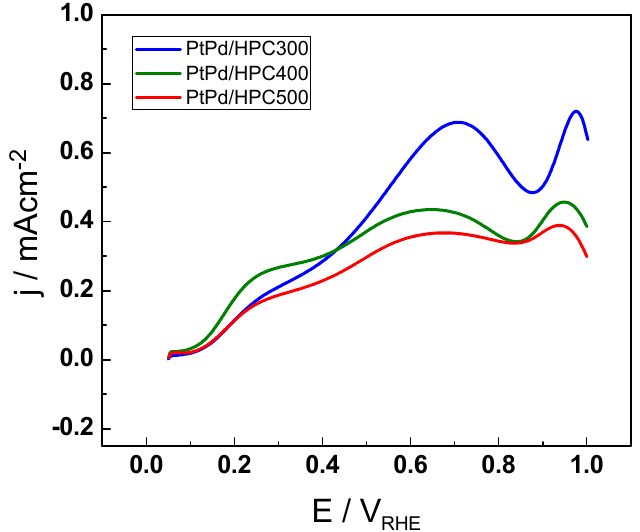
Figure 4. Cyclic voltammetry (CV) for PtPd/HPC300, PtPd/HPC400 and